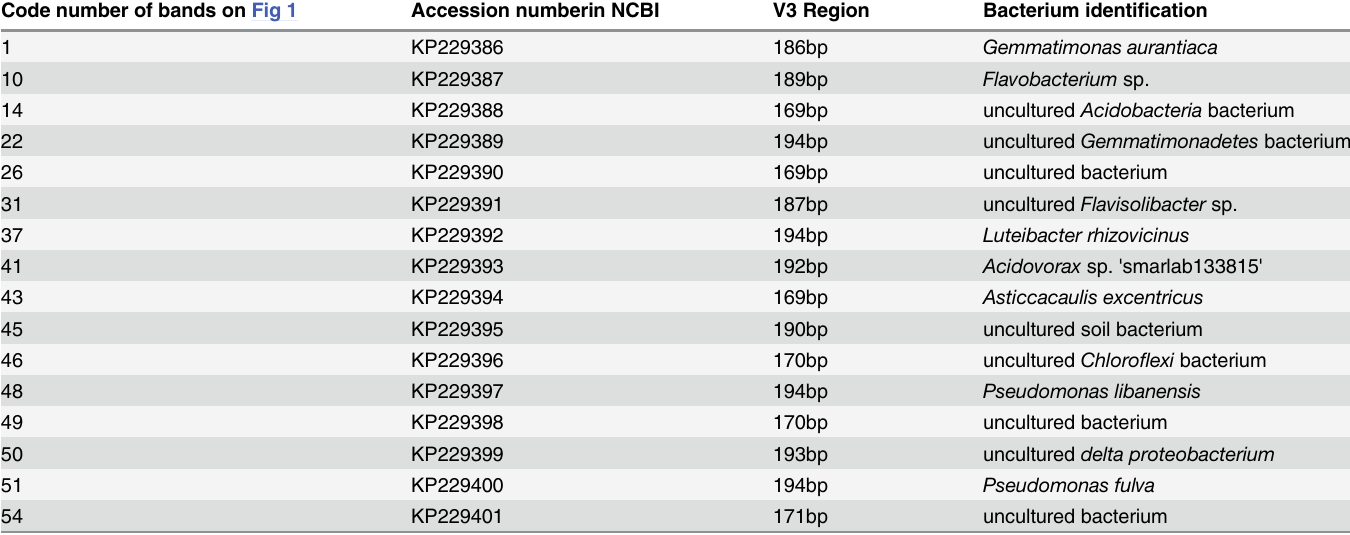
Table 5. Identification of bacteria for sixteen bands sequenced in the intercropping